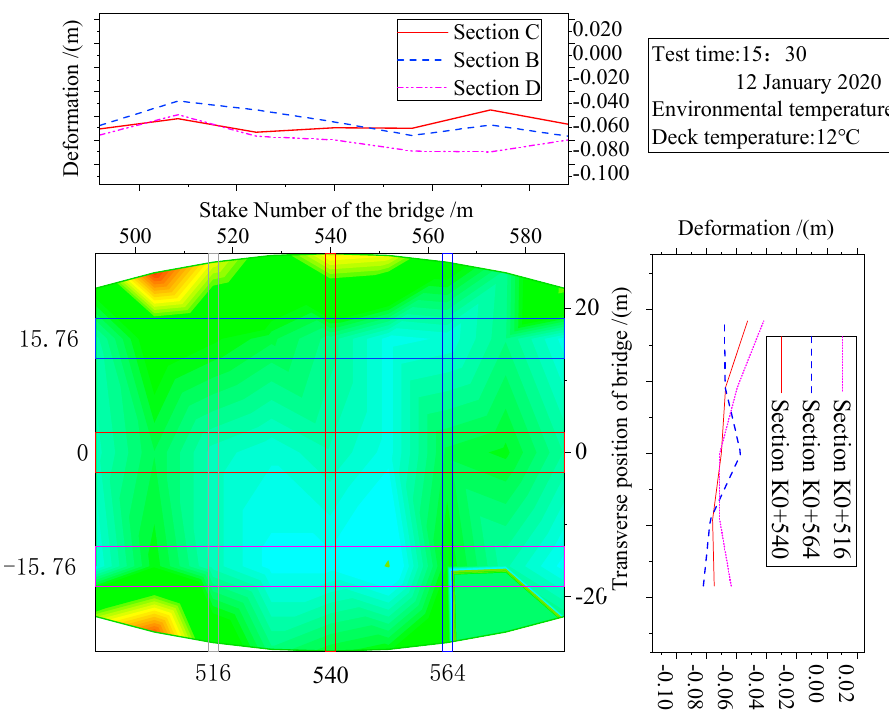
Figure 34. Deformation of the whole box girder after rehabilitation measures.